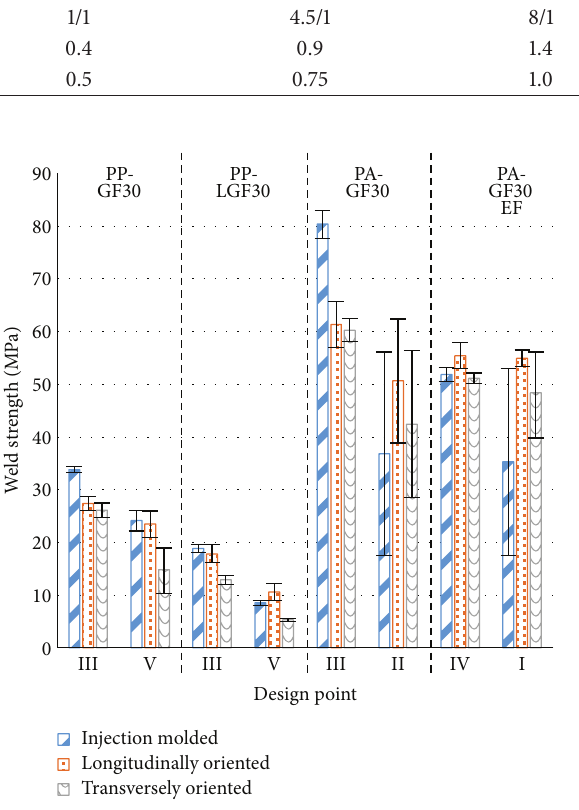
Figure 16: Weld strength in vibration welding for different initial fiber